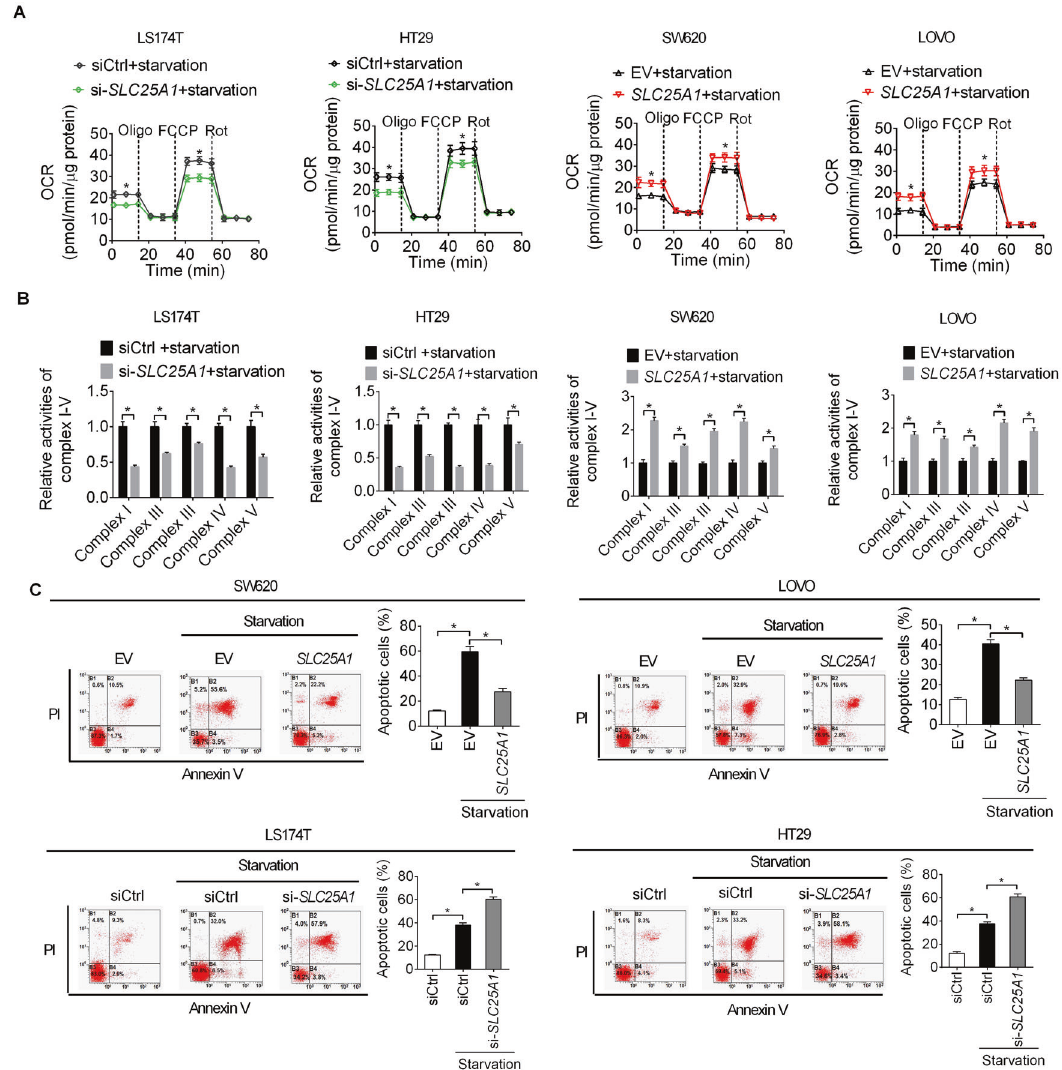
Fig. 6 SLC25A1 increased oxidative phosphorylation (OXPHOS) to promote cell survival during metabolic stress. A Oxygen consumption rate (OCR) was determined in CRC cells during metabolic stress (glucose starvation). B Activities of respiratory chain complexes I – V were determined in CRC cells during metabolic stress (glucose starvation). C Flow cytometry analysis for the role of SLC25A1 in the regulation of CRC cell apoptosis during metabolic stress (glucose